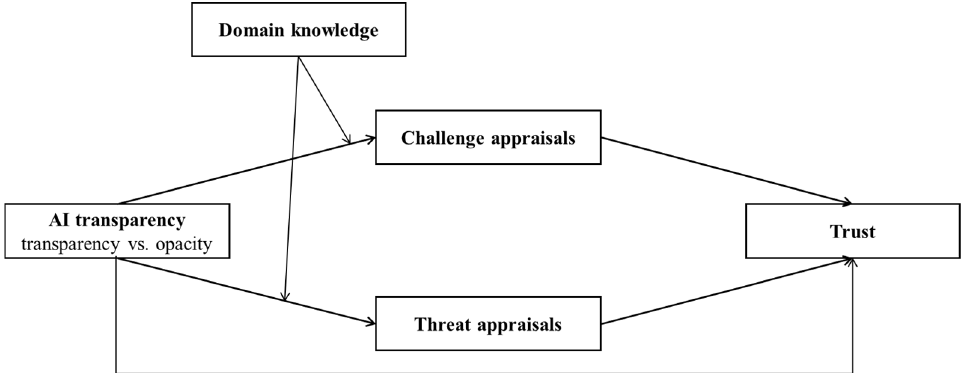
Figure 1. The theoretical model